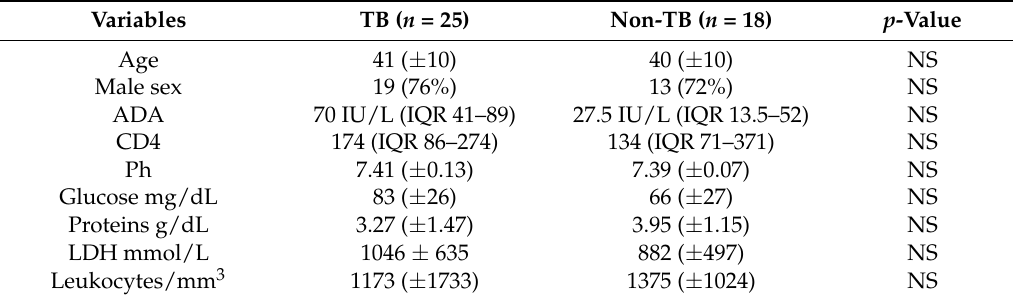
Table 1. Patients characteristics. Data are median (IQR), mean (SD), or n